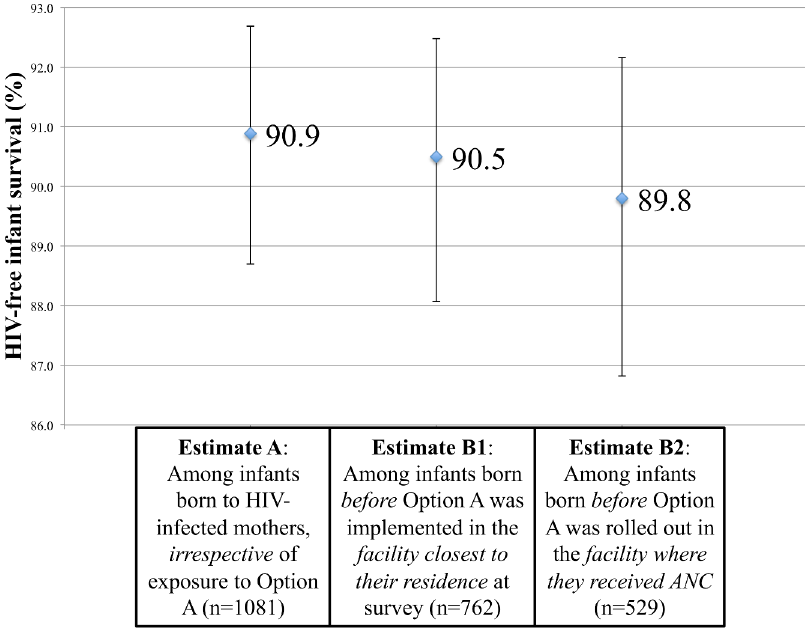
Fig 3. HIV-free infant survival at 9 – 18 months of age in five provinces in Zimbabwe, 2012. The figure shows estimates and 95% confidence intervals adjusted for the survey design. Weighted frequencies are shown on the x-axis. The sample size (unweighted) differs from that listed on Fig 4 due to missing data regarding the infants ’ status for a few mother-infant pairs.